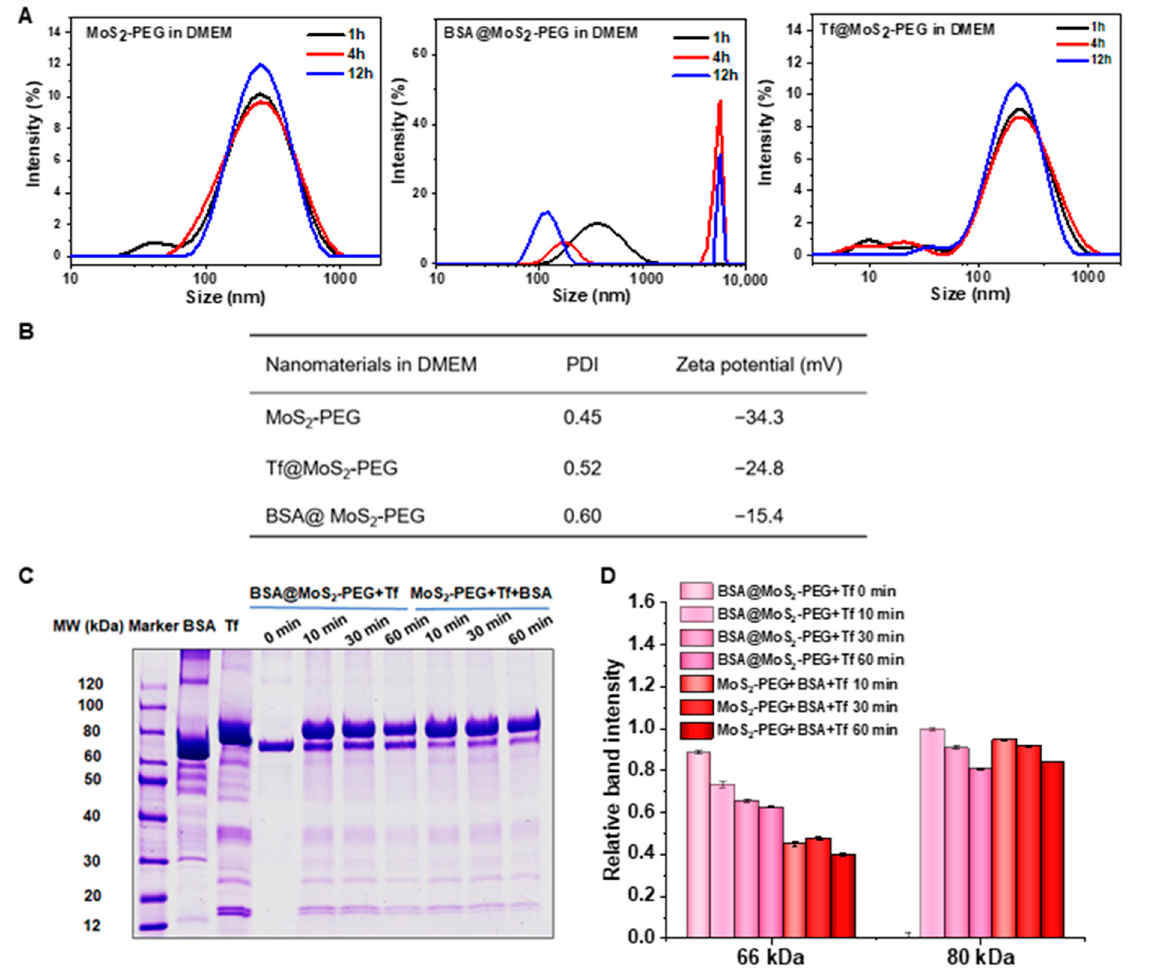
Figure 2. ( A ) Hydrodynamic size of MoS 2 -PEG, Tf@MoS 2 -PEG, and BSA@MoS 2 -PEG in DMEM. ( B ) Polydispersity index (PDI) and zeta potential of MoS 2 -PEG, Tf@MoS 2 -PEG, and BSA@MoS 2 -PEG in DMEM. ( C ) SDS-PAGE analysis of BSA@MoS 2 -PEG in Tf and MoS 2 -PEG in BSA and Tf solutions.